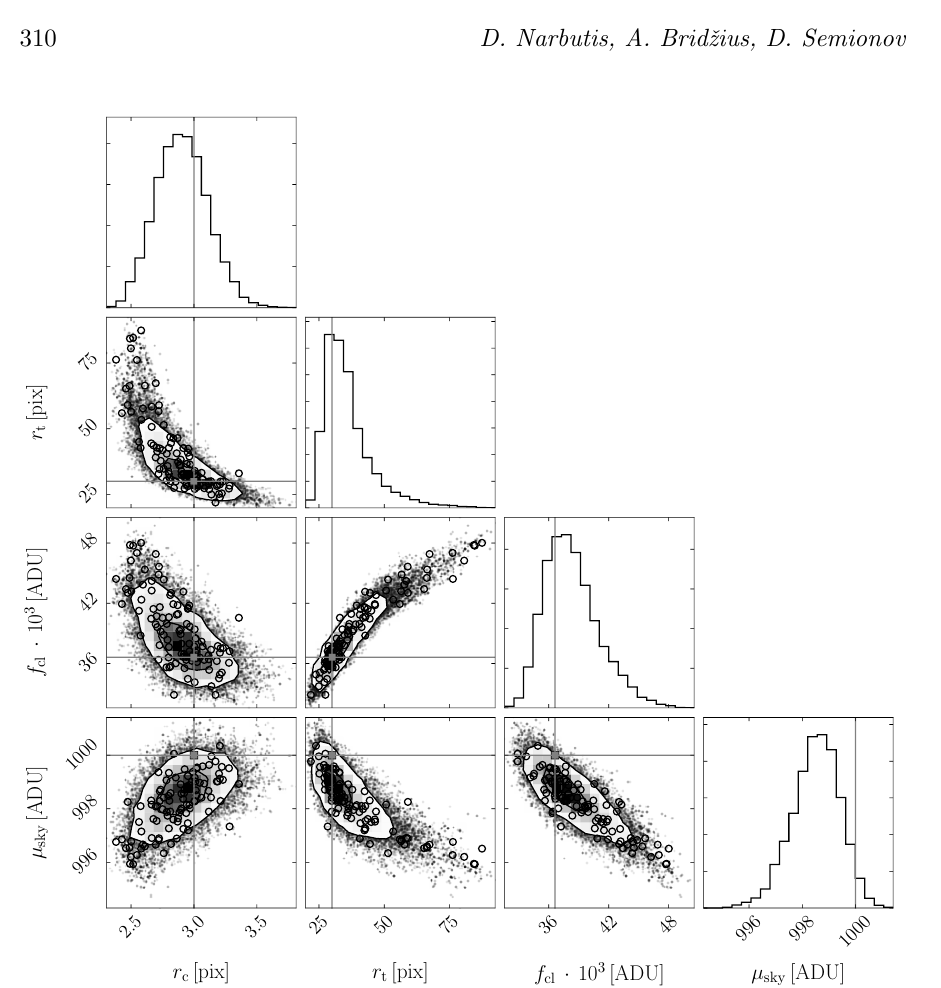
Fig. 3. Same as in Fig. 2, but for S/N = 50. Note the shorter range of axis